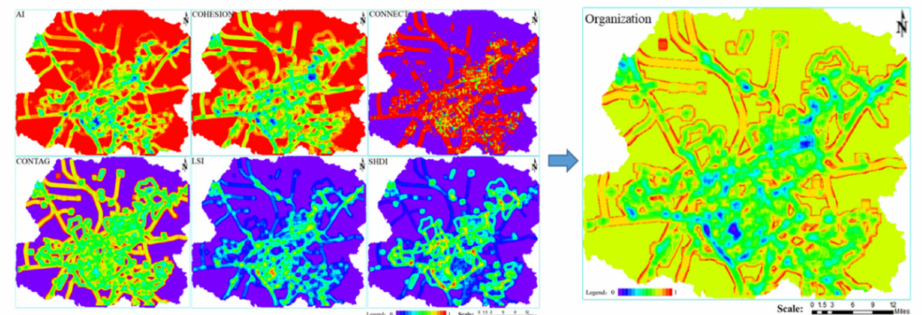
Figure 6. Spatial distribution map of the Organization.